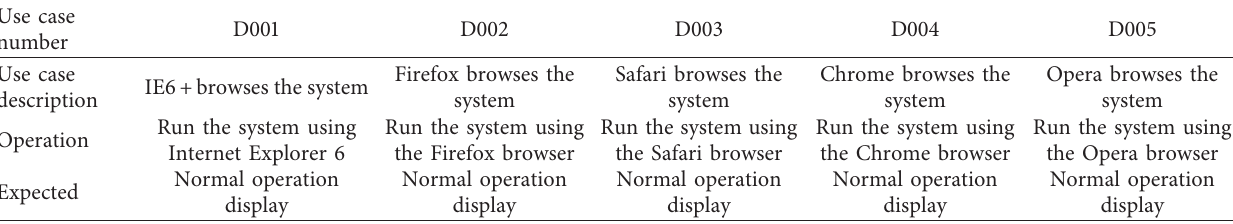
Table 1: Compatibility test description.